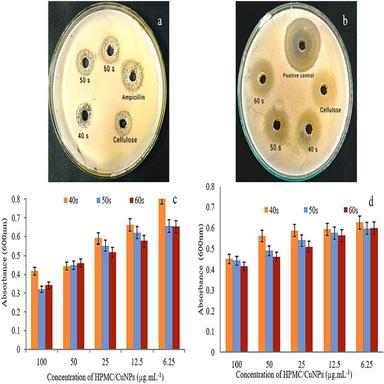
Agar well diffusion results of HPMC/copper nanoparticles: a) Escherichia coli b) Staphylococcus aureus. Minimum inhibitory concentration of E. coli of synthesized HPMC/copper nanoparticles. Minimum inhibitory concentration of S. aureus of synthesized HPMC/copper nanoparticles.